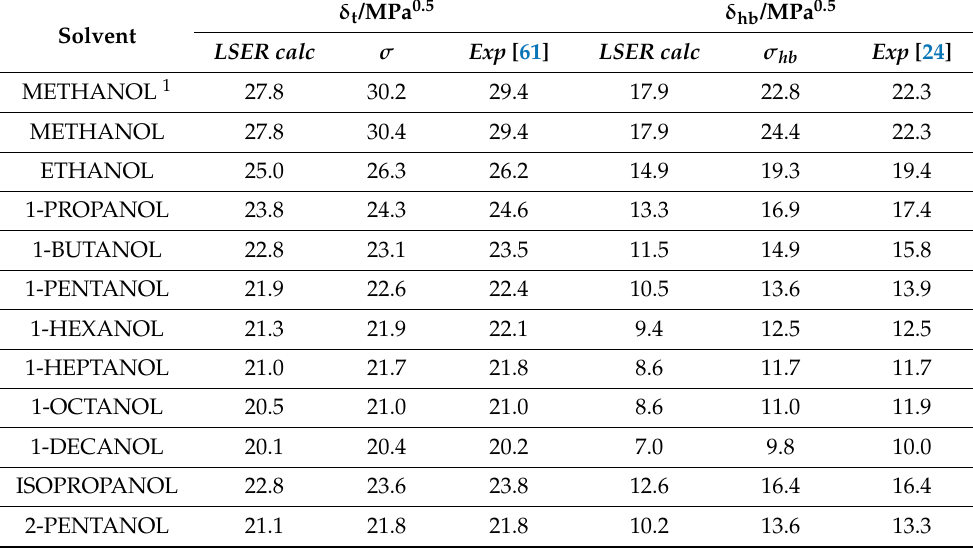
Table 3. The experimental and calculated total solubility parameters and hydrogen bonding solubility parameters of alkanols. LSER and PSP calculations were performed using the hydrogen bonding parameters presented in Tables 1 and 2,